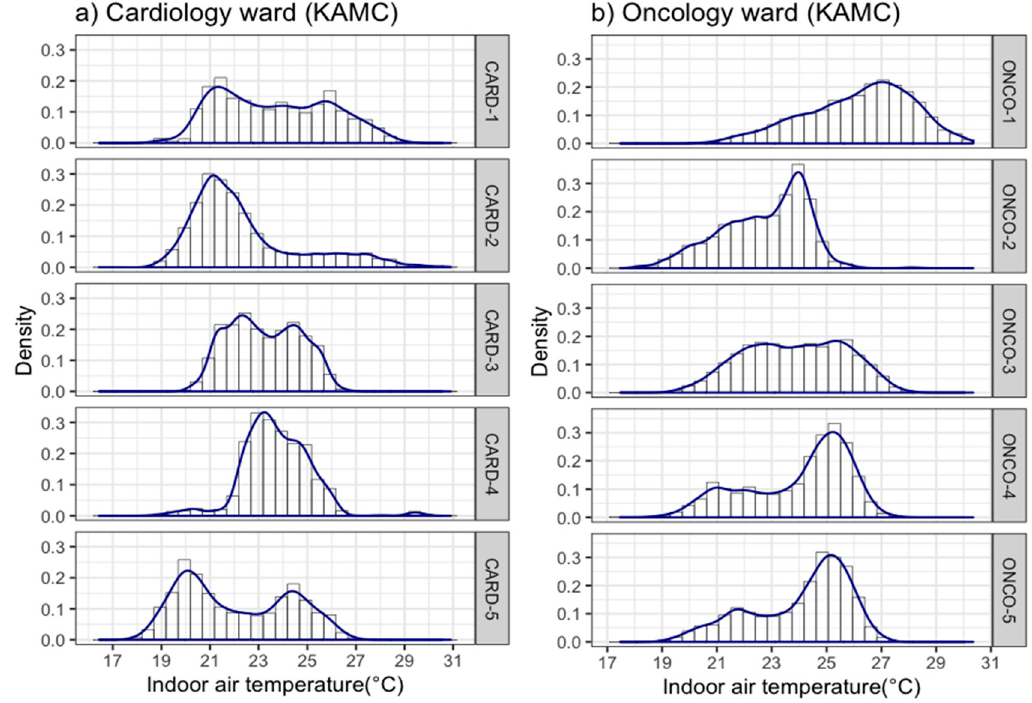
Figure 8. Distribution shapes of T a at KAMC (blue curve refers to kernel smoothing), ( a ) Cardiology ward (KAMC), ( b ) Oncology ward (KAMC) .